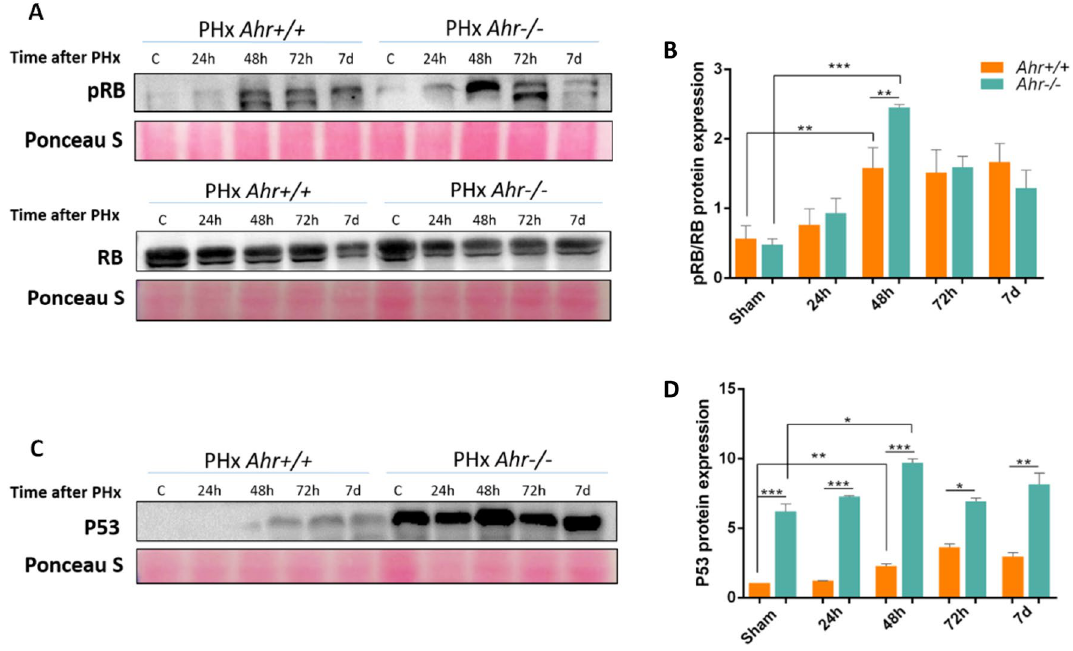
Figure 3. Proliferation rates are increased in livers of Ahr −/− mice after PHx. Protein expression of pRb (Ser 807/811) and Rb as determined by immunoblotting ( A ) and quantification of the pRb/Rb ratio ( B ) in liver extracts of Ahr + / + and Ahr −/− mice at the indicated time points after PHx. ( C , D ) Protein expression and densitometric quantification of p53 under the same experimental conditions. Ponceau staining was used to normalize protein levels. *p < 0.05, **p < 0.01, ***p < 0.001. Data are shown as mean ± SD. The experiments were performed using three mice per time point and three technical replicates were done. Antibodies used are indicated in Supplementary Table